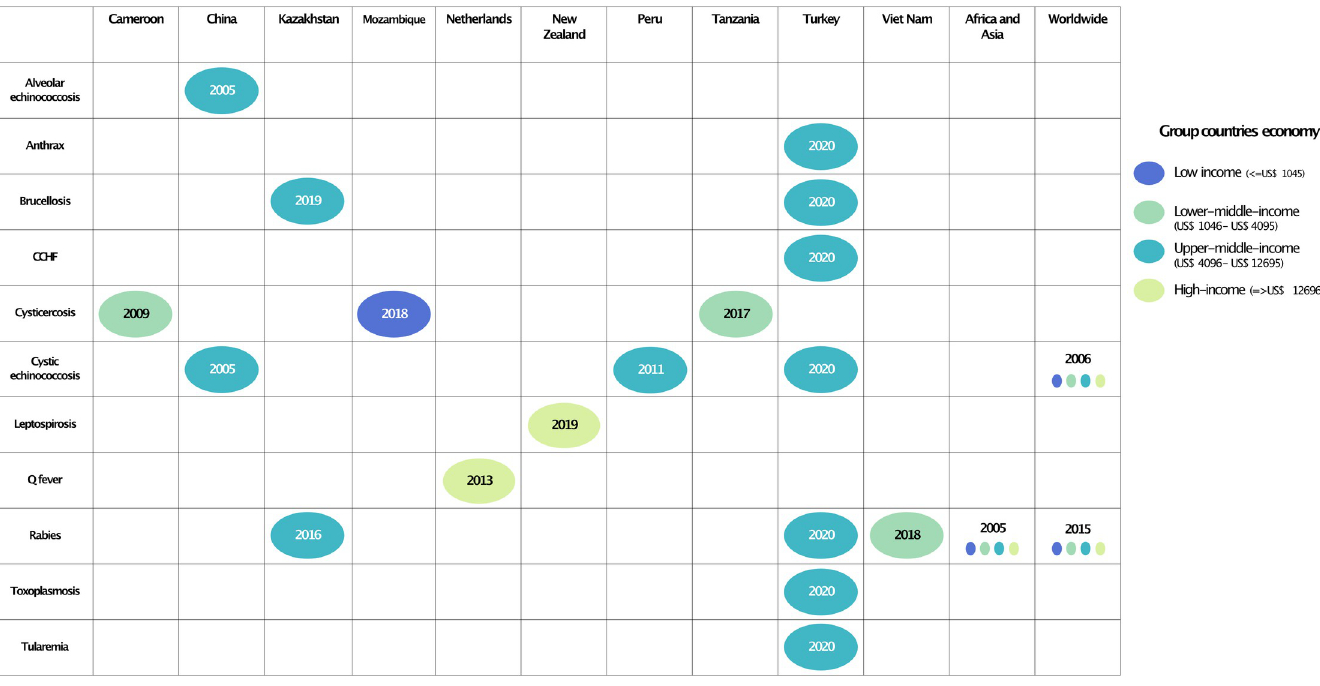
Fig 2. Zoonoses studied in humans and animals with their year of publication by income